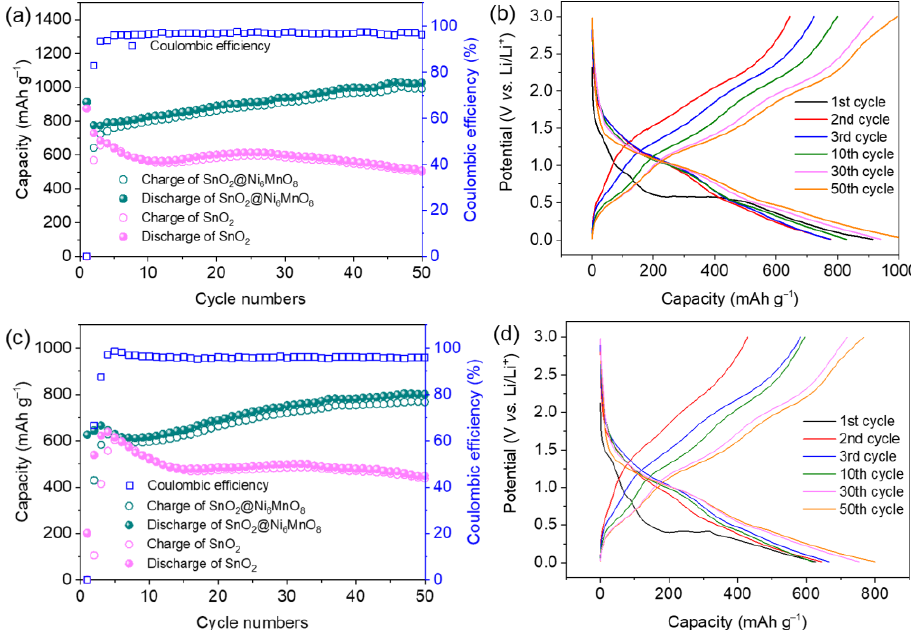
Figure 6. ( a ) Cycling performance of 3D SnO 2 @Ni 6 MnO 8 and SnO 2 anodes under 0.1 A g −1 . ( b ) Cor- responding charge – discharge profiles of SnO 2 @Ni 6 MnO 8 . ( c ) Capacity and ( d ) charge – discharge ( b ) Corresponding charge–discharge profiles of SnO 2 @Ni 6 MnO 8 . ( c ) Capacity and ( d ) charge– profiles under 0.5 A g −1 . discharge profiles under 0.5 A g − 1